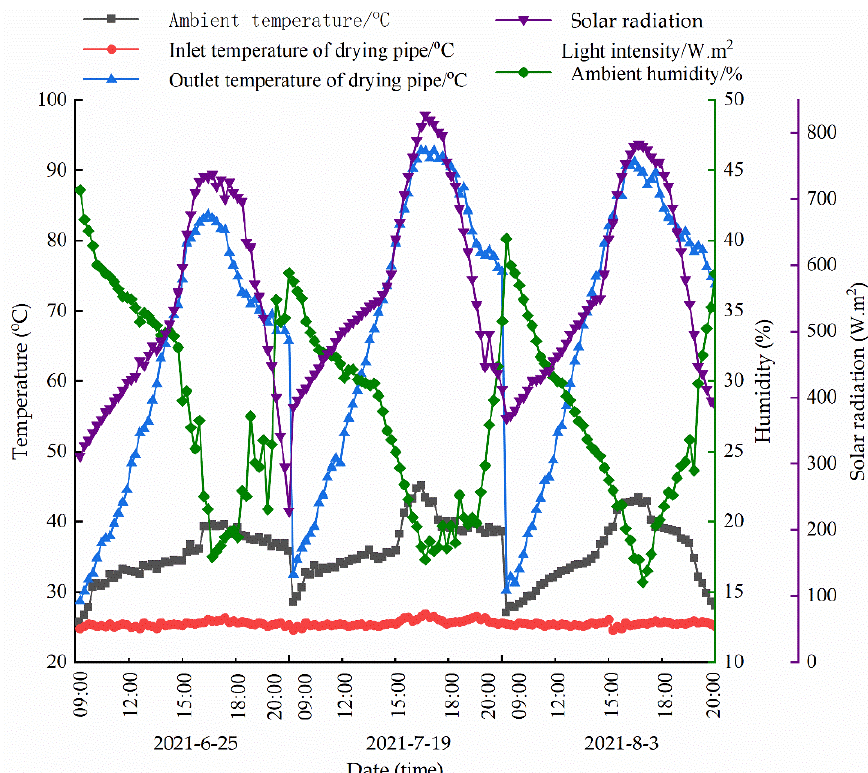
Figure 3. Heat-collection effect of the solar-cycle heat-collection